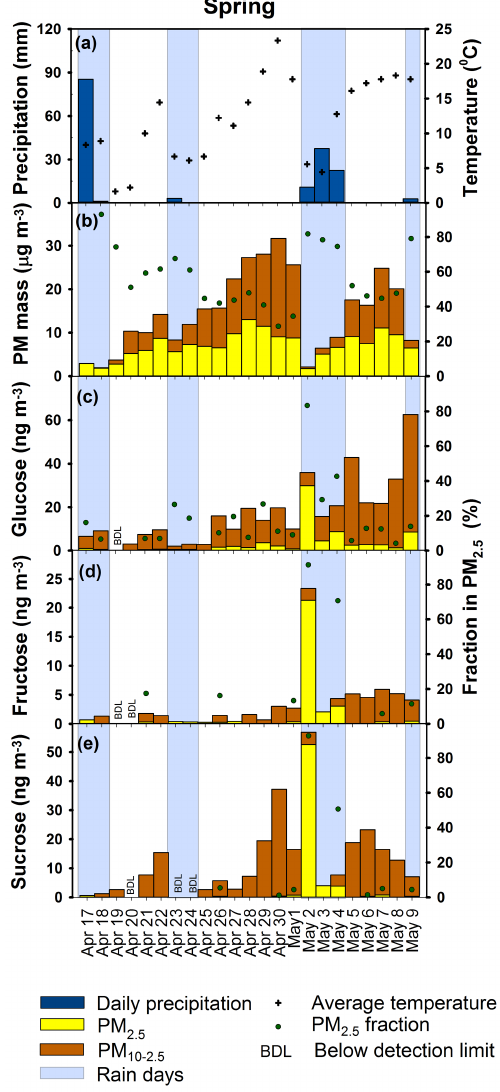
Figure 1. Temporal variation in precipitation and average temper- ature (a) in Iowa City, IA, in the spring of 2013. Ambient concen- trations of PM mass (b) , glucose (c) , fructose (d) , and sucrose (e) in coarse and fine size fractions. The percent of PM and bioaerosol tracer mass in fine particles is shown on the right axis for samples in which the analyte was detected in both size modes. During rain on 2 May, PM is suppressed, while pollen tracers in the fine mode substantially